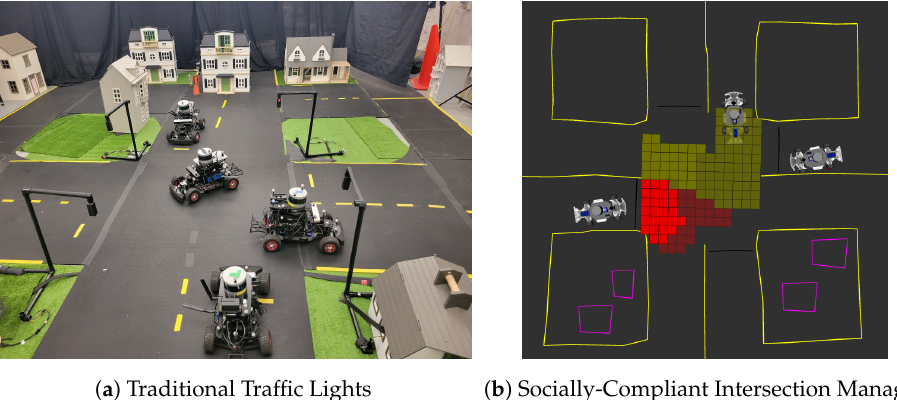
Figure 5. Traffic lights. ( a ) Multiple vehicles traverse intersections autonomously. ( b ) Traffic lights can operate in different modes, including intelligent socially-compliant reservation-based intersec- tion